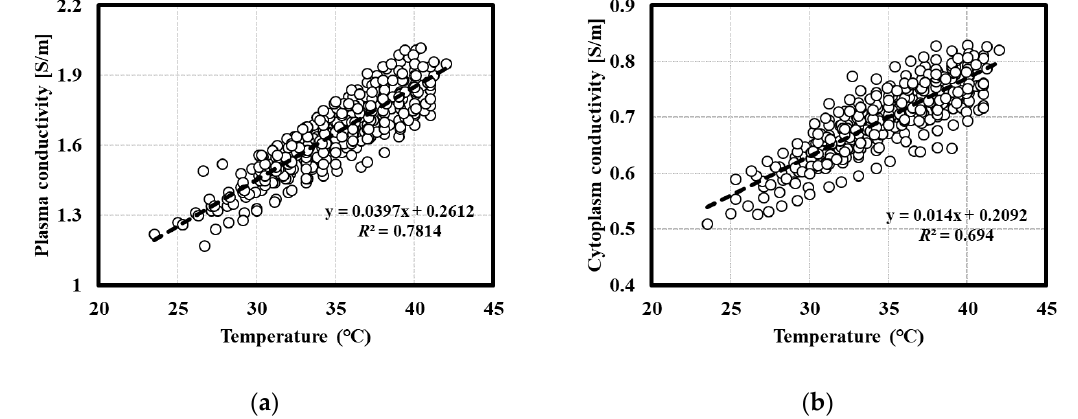
Figure 5. Temperature dependence of the conductivities of the plasma and cytoplasm. The electrical conductivities of the plasma and cytoplasm were extracted for 10 subjects. ( a ) Plasma conductivity. Linear regression was performed, and R 2 was calculated (0.0397𝑇 + 0.2612; 𝑅 2 = 0.7814) ; ( b ) Cytoplasm conductivity. Linear regression was performed, and R 2 was calculated ( 0.014𝑇 + 0.2092; 𝑅 2 = 0.694 ).